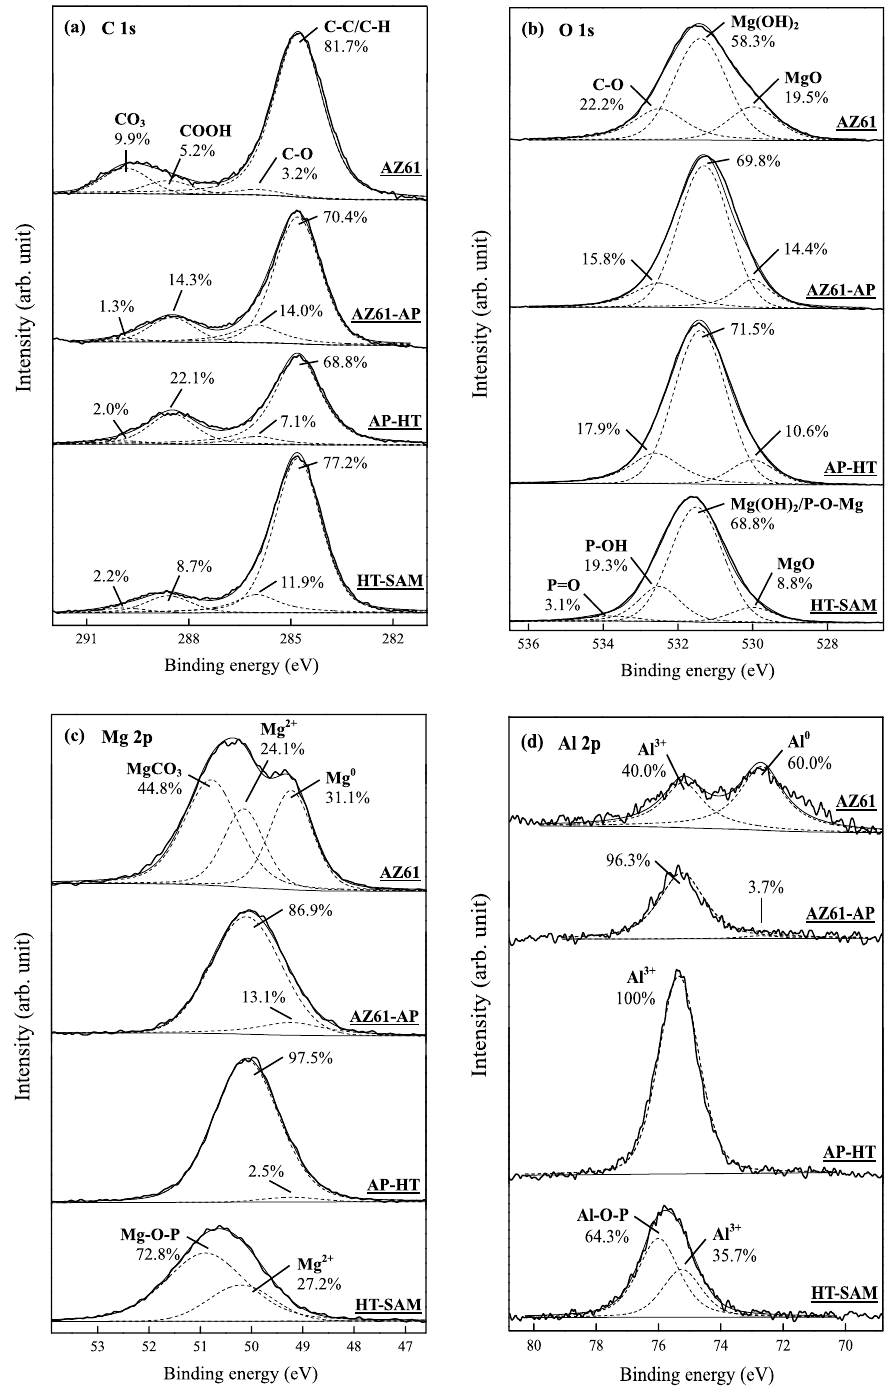
Figure 5. Effect of various surface treatments on the high-resolution XPS spectra of ( a ) C 1 s , ( b ) O 1 s , ( c ) Mg 2 p and ( d ) Al 2 p regions with curve-fitting analysis